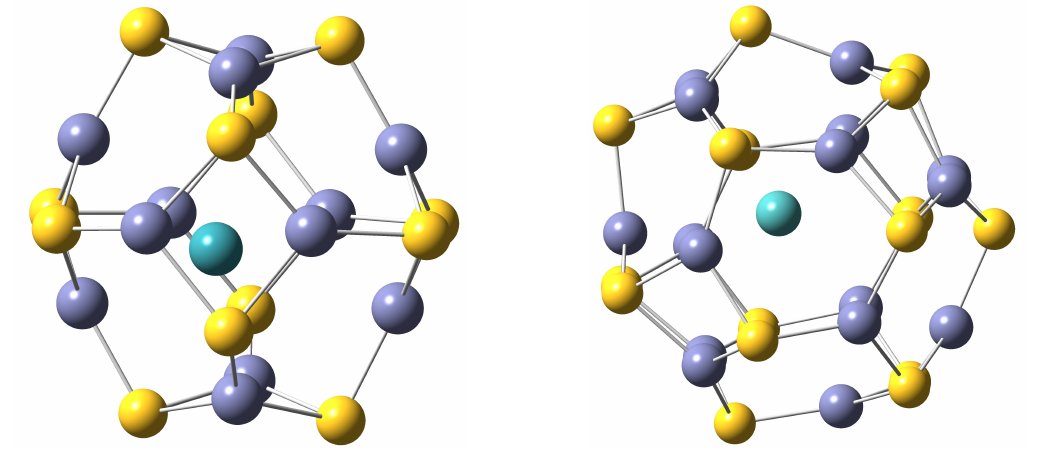
Figure 1. On the left TM@Zn S atoms are drawn in yellow, Zn atoms in violet and TM in